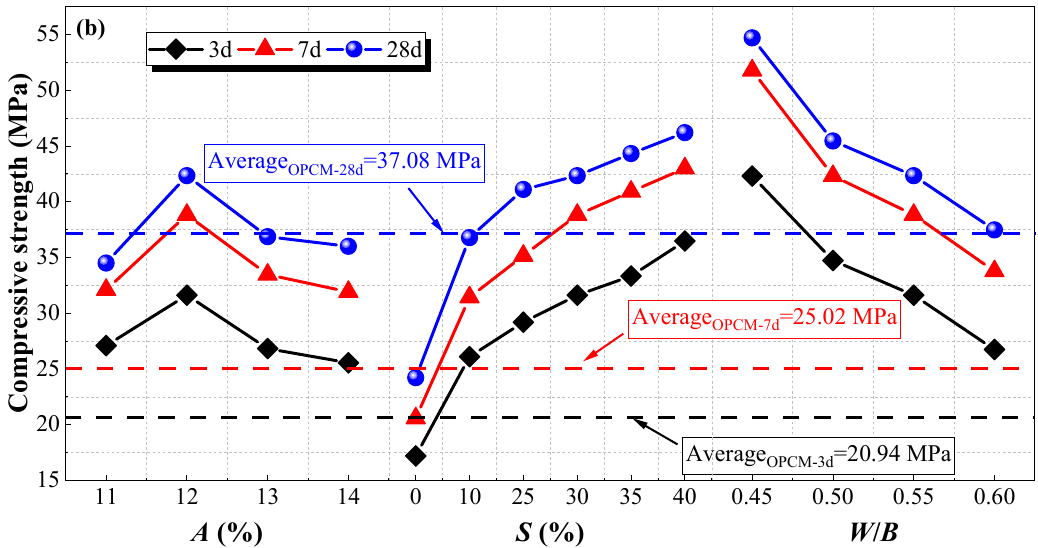
Figure 5. Mechanical properties of CGBGM with different parameters: ( a ) flexural strength; ( b ) com- pressive strength.